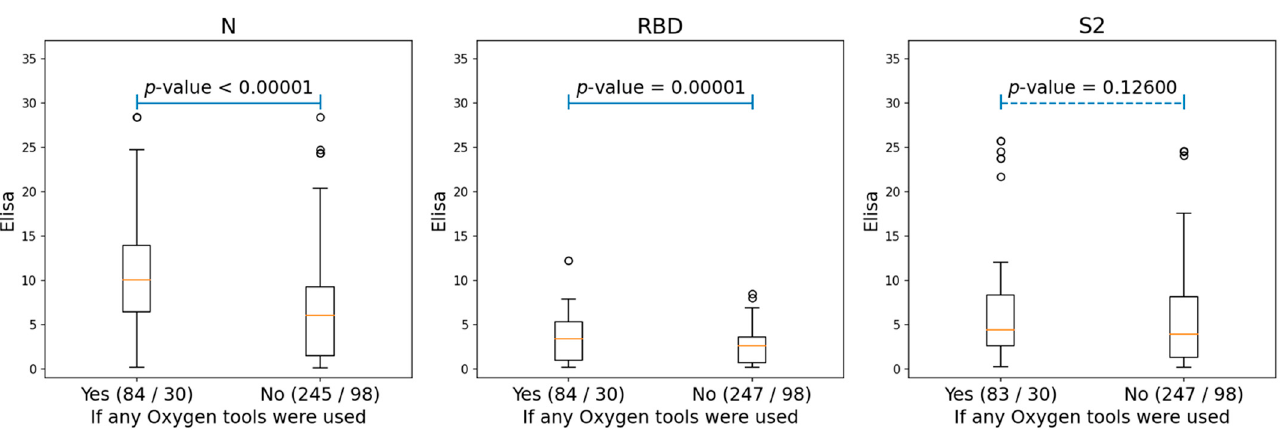
Figure 2. The boxplots, showing the differences for the ELISA values of N, RBD, and S2 proteins among the patients who needed oxygen support and those who did not. The ‘Yes’ group, indicating patients who used any oxygen tools (either nasal cannula or supplementary oxygen) and the ‘No’ group, consisting of patients without any oxygen tool interventions. The two numbers in braces for each group indicated the number of Elisa samples and patients correspondingly. The p -values were produced by performing ANOVA tests for each of the two